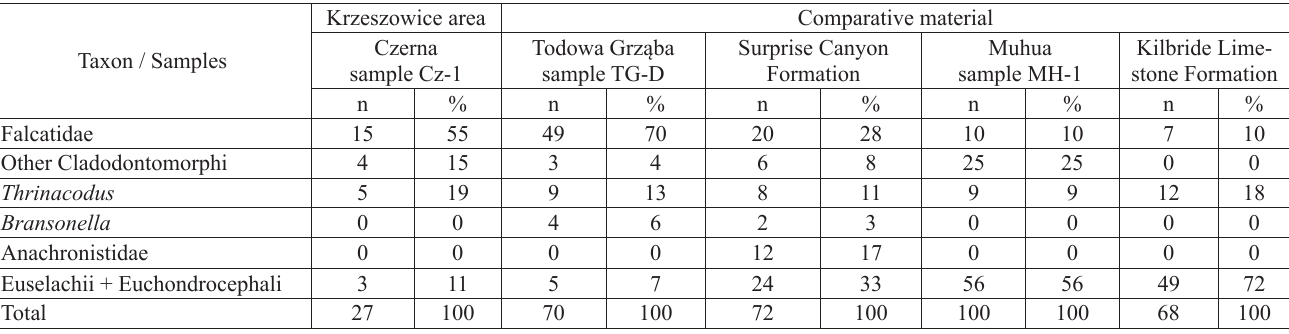
Table 2. Comparison of Mississippian chondrichthyan assemblages from the area of Krzeszowice (this paper), Todowa Grz ą ba (Holy Cross Mountains, Poland; Ginter et al. 2015), Surprise Canyon Formation (middle member, Northern Arizona, USA; Hodnett and Elliott 2018), Muhua (southern China; Ginter and Sun 2007), and Kilbride Limestone Formation (Nobber, Ireland; Duncan 2003, 2004, 2006); n, number of specimens.